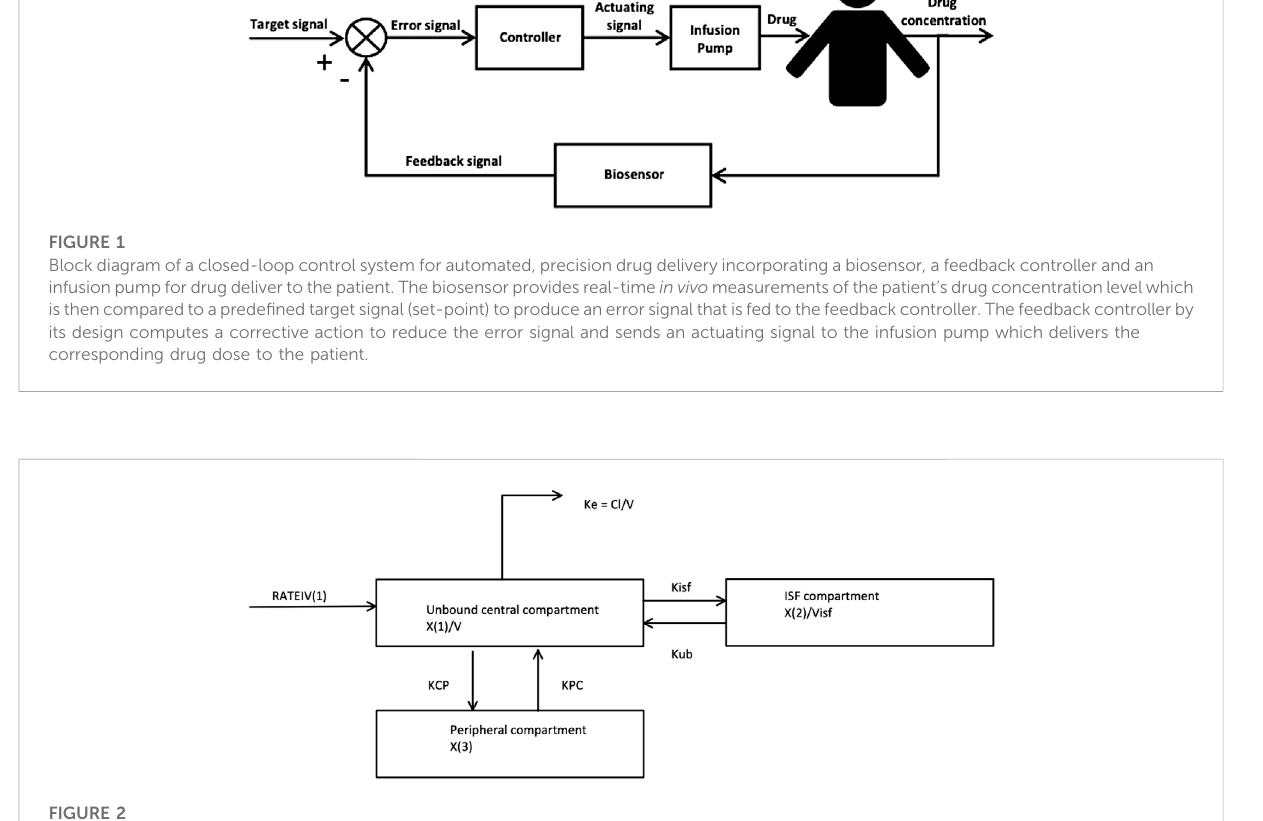
FIGURE 2 The Piperacillin pharmacokinetic compartment model selected and fi t to simulate the 20 virtual critically-ill patients. This is a 3 compartment model with an unbound central, ISF and peripheral compartment. RATEIV is the rate of the IV drug delivery. KCP and KPC are transfer coef fi cients to and from the Peripheral compartment, respectively. Kisf and Kub are transfer coef fi cients to and from the ISF compartment, respectively. V is the volume of the central compartment. Visf is thevolume of theISF compartment. X (1), X(2) and X (3) are theamount of the drug in the Unbound, ISF and Peripheral compartments respectively. Ke is the elimination rate